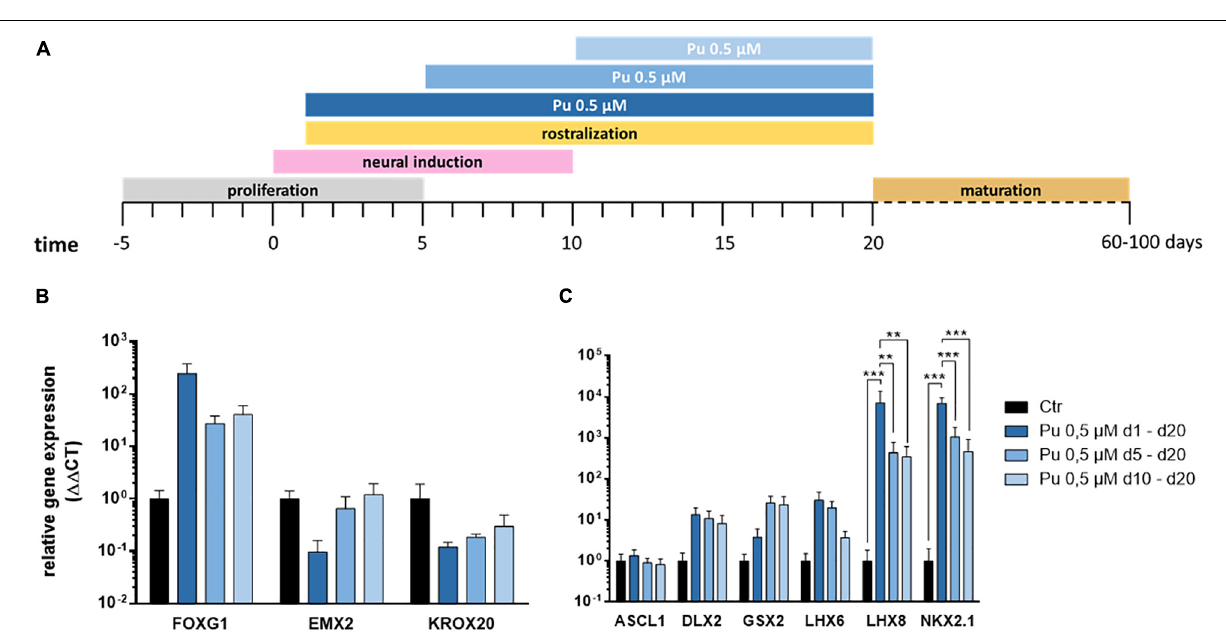
FIGURE 4 | Screening for most effective timing for the application of purmorphamine. (A) Different time intervals for ventral patterning. After regionalization (day 20) the rostro-caudal (B) and dorso-ventral (C) identity was assessed, Pu-treated values are relative to Ctr; n = four differentiations, four hiPSC lines. Statistical analysis: two-way ANOVA, correction for multiple testing by the Tukey method, error bars correspond to the SEM. Significant with p -value < 0.005 (**), < 0.0005